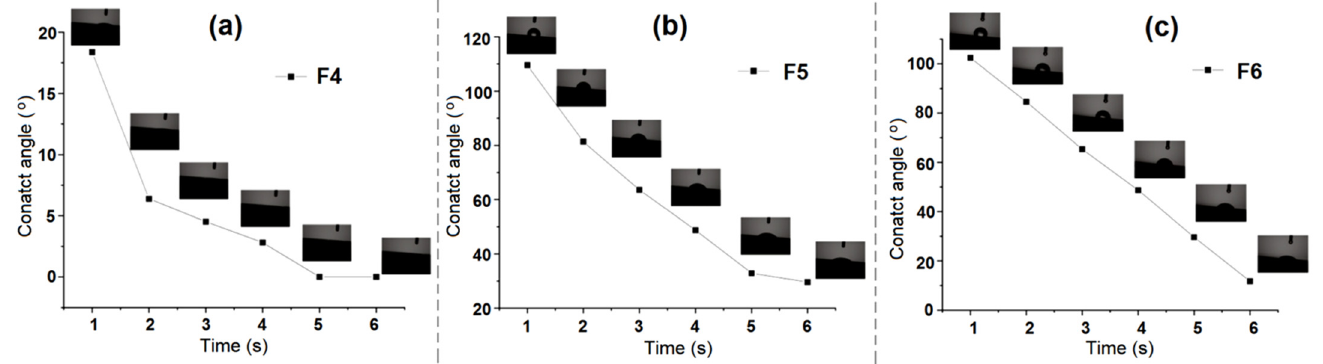
Figure 7 . Water contact angle of nanofiber membranes: ( a ) F4; ( b ) F5; ( c )